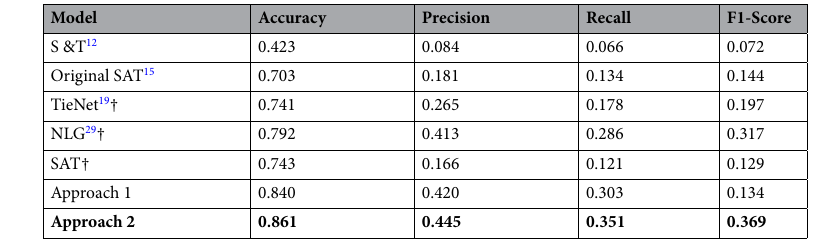
Table 2. The clinical efficacy (CE) metrics on the MIMIC-CXR dataset. The best results are highlighted in bold. Models labelled with † stand for the models we implemented and trained with the preprocessed MIMIC- CXR data. Other results are cited from the original papers.